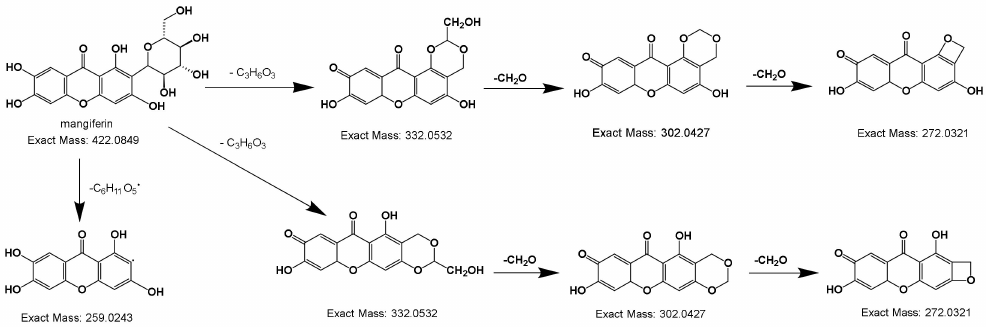
Figure 6. Deductive fragmentation pathway of mangiferin.